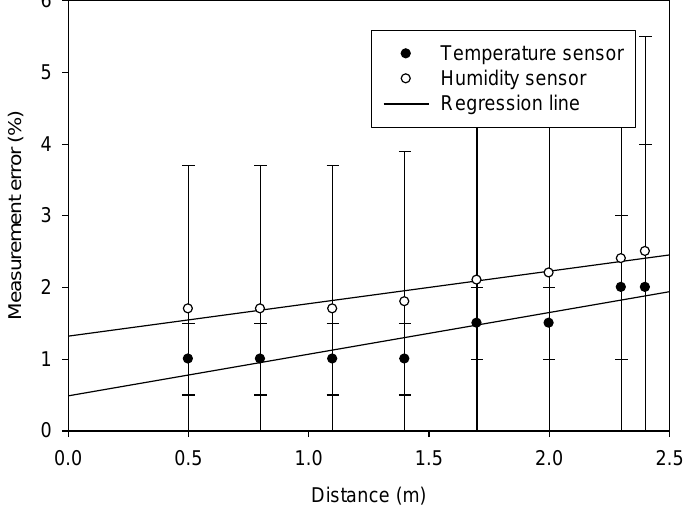
Figure 18. Measurement error of a WPWS equipped with temperature and humidity